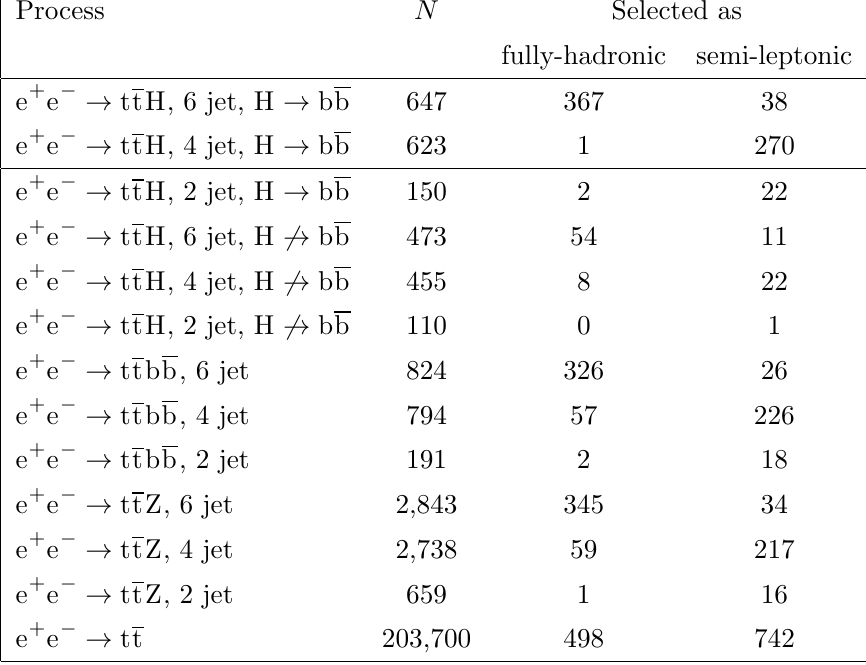
Table 13. Expected numbers of signal and background events in the fully-hadronic and semi- p leptonic channels for 1 : 5 ab (cid:0) 1 at s = 1 : 4 TeV. The columns show the total numbers of events before selection and the numbers of events passing the fully-hadronic and semi-leptonic BDT selec- tions. No preselection is applied in the